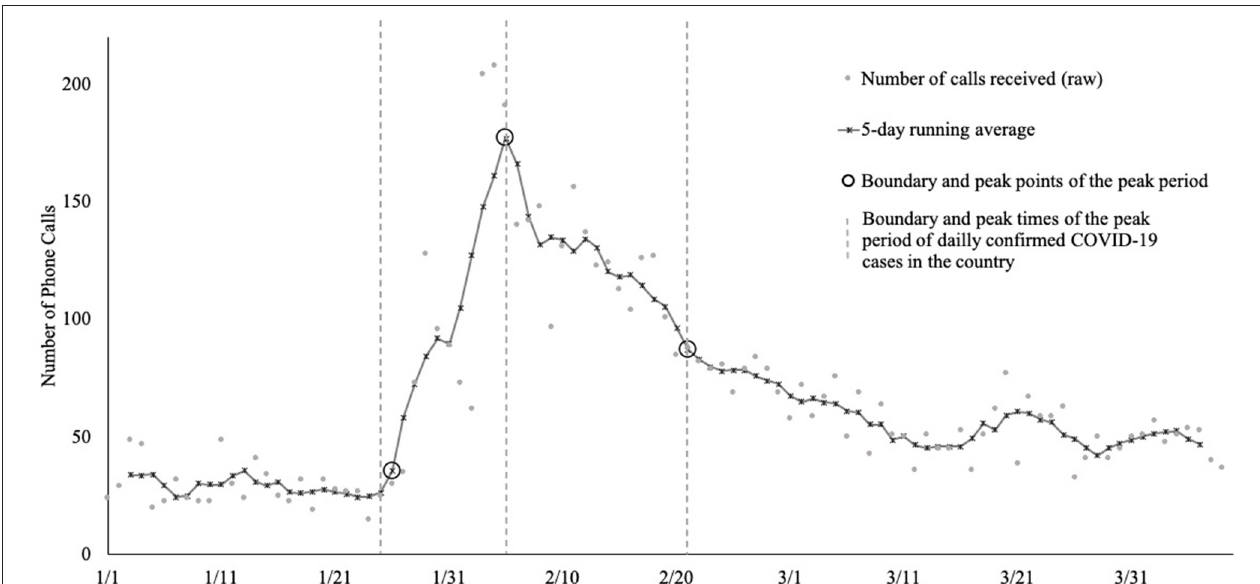
FIGURE 1 | The daily number of phone calls received at the regional hotline from January 1st, 2020, till April 8th, 2020, and 5-day running averages. The number of phone calls showed a monotonic increase since the day COVID-19 cases were reported in this region, peaked on the day the sub-regional hotlines started to operate, and started to show monotonic decrease afterward. The peak period spanned 27 out of the 79